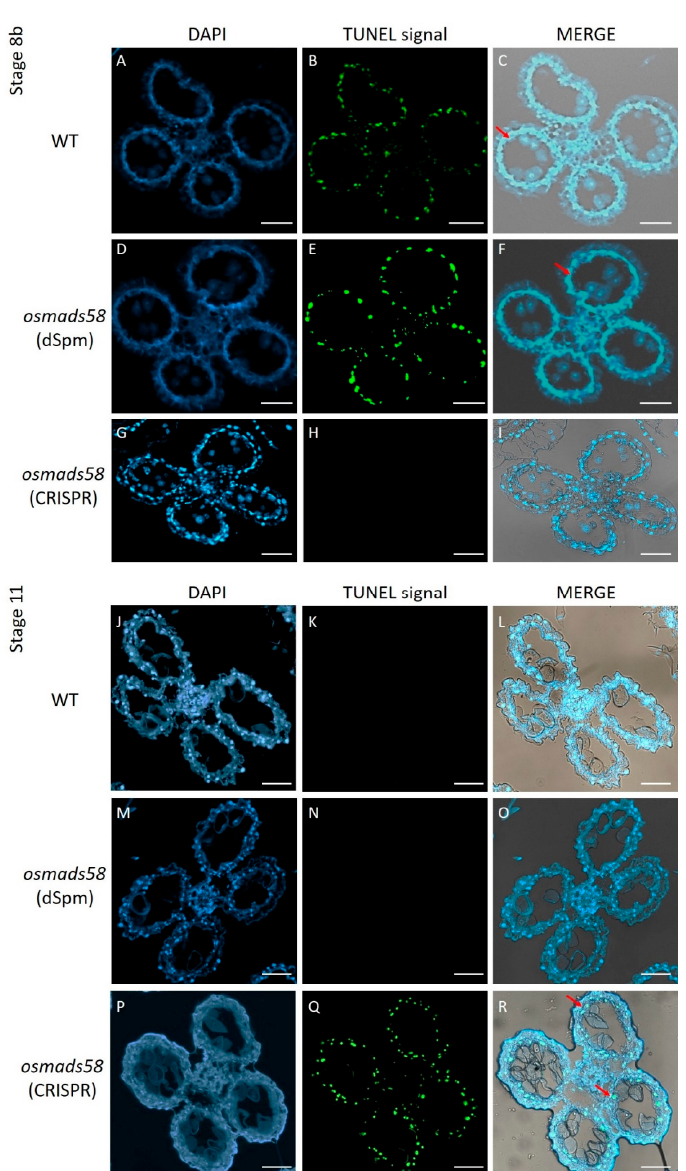
Figure 4. TUNEL assay of DNA fragmentation in tapetum tissue from wild-type, osmads58 dSpm, and osmads58 CRISPR lines. ( A – I ) Wild-type ( A – C ), osmads58 dSpm ( D – F ), and osmads58 CRISPR ( G – I ) anthers at stage 8. The tapetum of the wild type started to degrade, but osmads58 CRISPR had no degradation signal at stage 8. ( J – R ) Wild-type ( J – L ), osmads58 dSpm ( M – O ), and osmads58 CRISPR ( P – R ) anthers at stage 11. The tapetum degradation of the wild type had completed, but the osmads58 CRISPR still had degradation signals at stage 11. Blue signal indicates 4 (cid:48) ,6-diamidino-2-phenylindole (DAPI) staining, while green fluorescence indicates a TUNEL positive signal. ( C , F , I , L , O , R ) Merged images of DAPI staining, TUNEL signal, and bright-field micrographs. The red arrows show the TUNEL positive signal in the tapetum. Bar, 50 µ